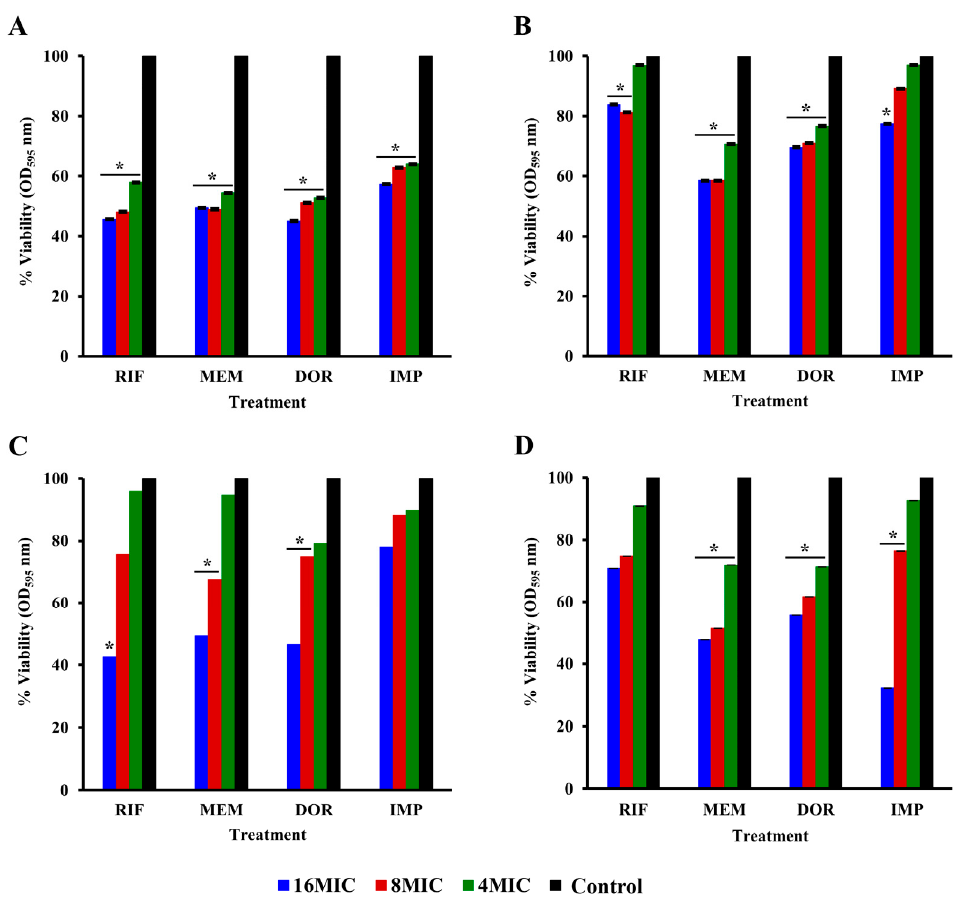
Figure 5. Cell viability of monotherapy against 96 h-established biofilm ( A ) SK015, ( B ) SK024, ( C ) TR125, and ( D ) TR045 expressed as percentage viability. MIC, minimum inhibitory concentration; RIF, rifampicin; MEM, meropenem; DOR, doripenem; IMP, imipenem. * p < 0.05.